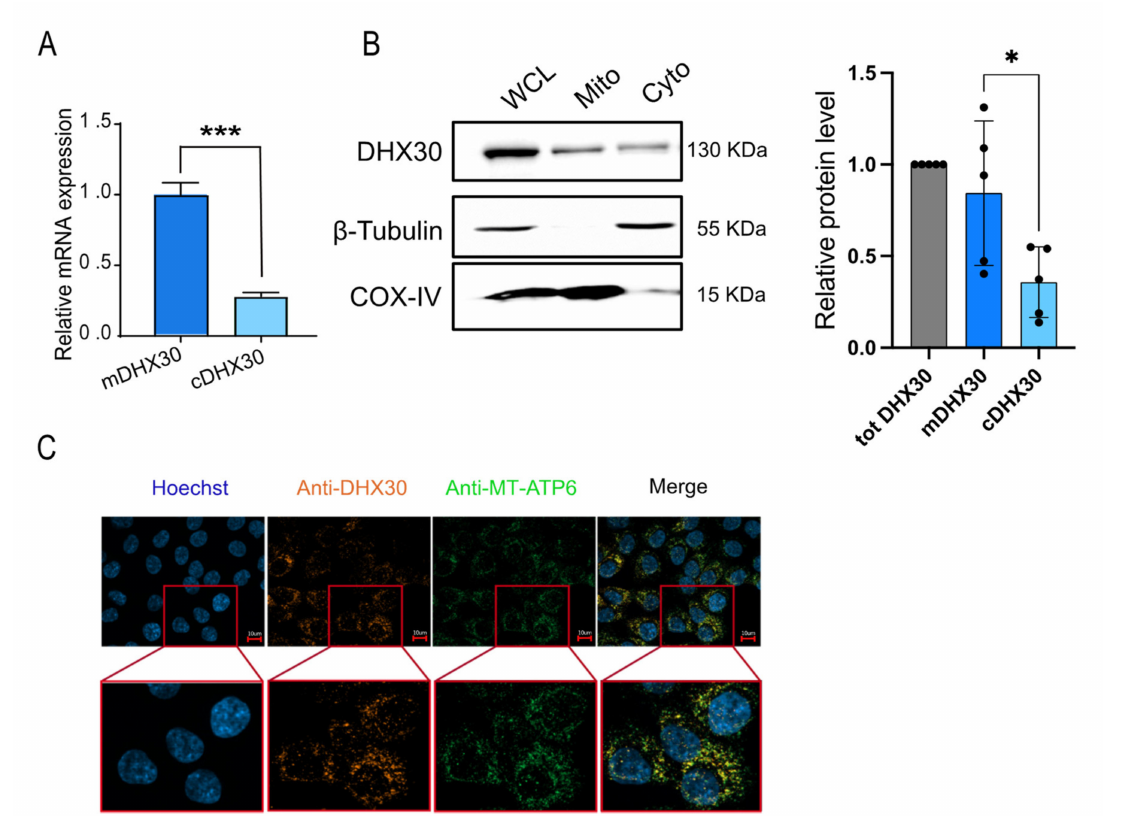
Figure 3. Subcellular localization of DHX30. ( A ) Relative mRNA levels of cytoplasmic DHX30 (cDHX30) and the mito- chondrial variant (mDHX30, set to 1). Data are mean ± SD (n = 3); *** p < 0.001, t -test. ( B ) Relative DHX30 protein levels in whole cell lysates (WCL), mitochondrial (Mito), and cytoplasmic (Cyto) fractions. β -Tubulin and COX-IV were used as controls of cytoplasmic-mitochondrial fractionation. One of five independent experiments is shown. The graph on the right plots the relative DHX30 protein levels obtained from densitometric quantification of all the blots and relative to the reference proteins; * p < 0.05, t -test. tot DHX30: DHX30 protein in the whole cell lysate; mDHX30 and cDHX30: DHX30 protein in mitochondrial and cytoplasmic fractions, respectively. ( C ) Representative images of one of three independent immunofluorescence experiments to colocalize DHX30 (orange) with MT-ATP6 (green, used as mitochondrial marker). Staining with Hoechst (blue) was used to visualize cells’ nuclei. The uncropped blots are shown in supplementary